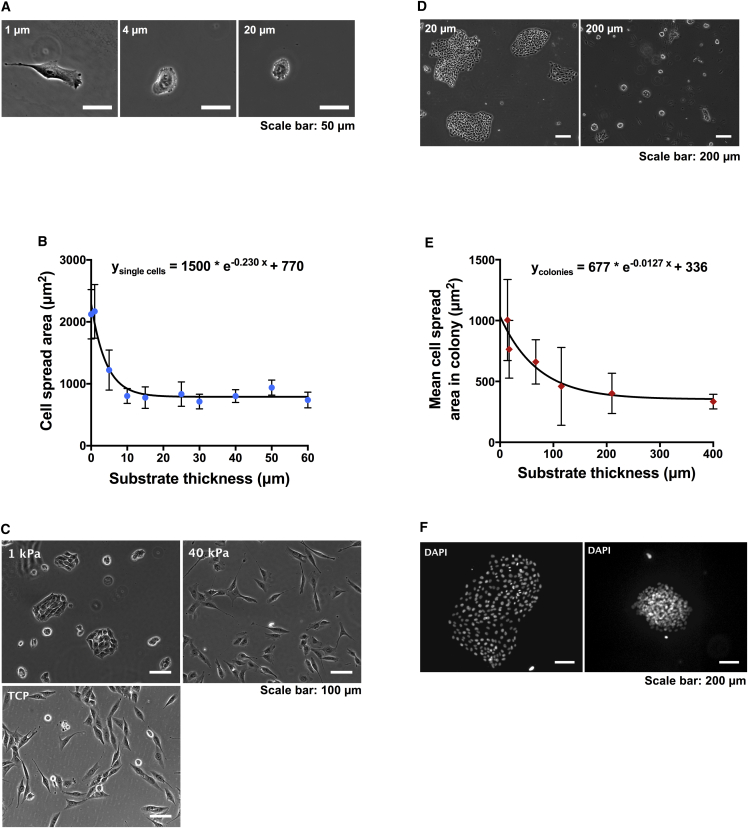
MG63 colonies mechanosense boundaries at greater depths than individual cells. (A) On hydrogels with the same elastic modulus (1-kPa), MG63 spread to a greater degree on thin compared to thick hydrogels, as shown by phase-contrast micrographs. (B) Mean cell area decreased asymptotically as thickness increased to a threshold of ∼10 μm, with the data fitting to an exponential model (R2 = 0.960) with a half-maximal response (ln2/k) at 3 μm. Data presented as mean ± SD for n = 3–10 single cells. (C) When plated on 1-kPa hydrogels of thickness 200 μm, MG63 cells formed discrete colonies, in contrast to on stiff (40-kPa) hydrogels or tissue culture plastic. (D) Colonies cultured on thin hydrogels (∼20-μm) appeared well-spread, with each cell in the colony visible. In contrast, on thick hydrogels (200-μm), colonies are round and densely packed with cells. (E) The area occupied by a cell in a colony decreased asymptotically as a function of thickness. The data were fitted to an exponential model (R2 = 0.916) with a half-maximal response of 54.4 μm and a maximal density at thickness >200 μm. (F) DAPI staining showed that on thin hydrogels, nuclei were well-separated (left), but on thick hydrogels, nuclei density was greater (right). To see this figure in color, go online.